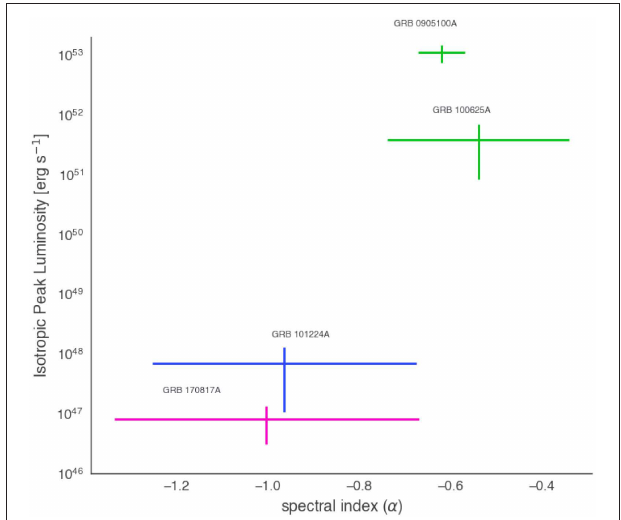
FIGURE 4 | The isotropic luminosity of the peak flux bin for each GRB with redshift in our sample. Both local GRBs exhibit isotropic luminosities of about 1,000 times less and spectra markedly softer than those at larger distances. If we assume that high observed flux sGRBs are the result of on-axis emission, then we expect them to have harder observed spectra and high intrinsic